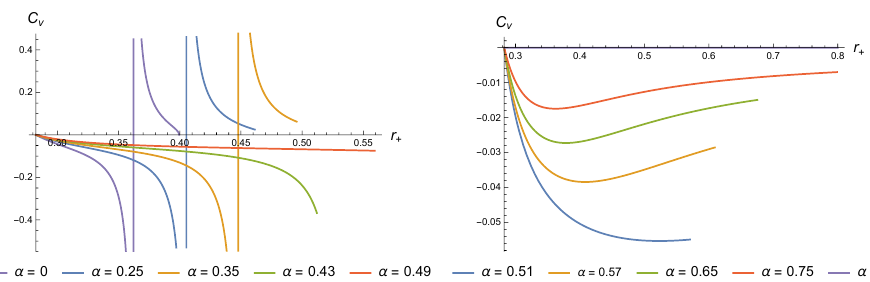
Figure 2 . C V of generalized exotic black holes. Left : (cid:11) < 1 = 2, right : (cid:11) > 1 = 2. In all cases, P = 1 ; J = 0 :